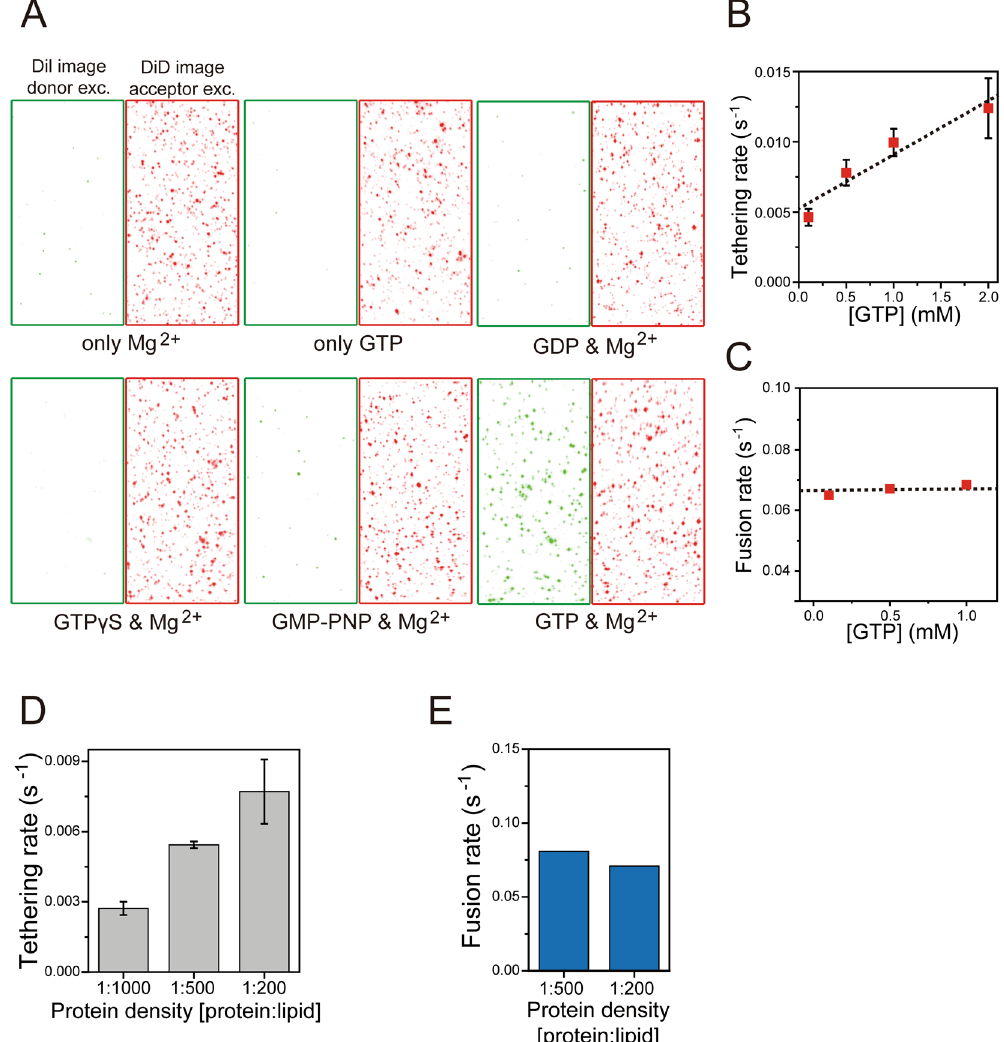
only, 1 mM GDP with 2 mM Mg 2 + , 1 mM GTP γ S with 2 mM Mg 2 + , 1 mM GMP-PNP with 2 mM Mg 2 + , and 1 mM GTP with 2 mM Mg 2 + ). ( B,C ) Tethering ( B ) and fusion ( C ) rates at varying GTP concentrations. The Mg 2 + concentration was 2-fold higher than the GTP concentration in the GTP titration experiments. To clearly visualise the correlation of tethering or fusion rates with GTP concentrations, a linear fit line for the tethering rate and the average value of the entire data set for the fusion rate were added. In ( B ), error bars represent standard deviations obtained from two or three independent experiments. ( D,E ) Comparison of tethering ( D ) and fusion ( E ) rates at varying protein densities on the vesicle surface. The protein density on the membrane surface was represented as the protein-to-lipid ratio. Error bars represent standard deviations obtained from at least three independent experiments ( D ). Each data point was generated by dwell time analysis of at least 100 fusion events obtained from several independent experiments ( C,E ). Experiments were performed using proteoliposomes with a protein-to-lipid ratio of 1:200, unless otherwise